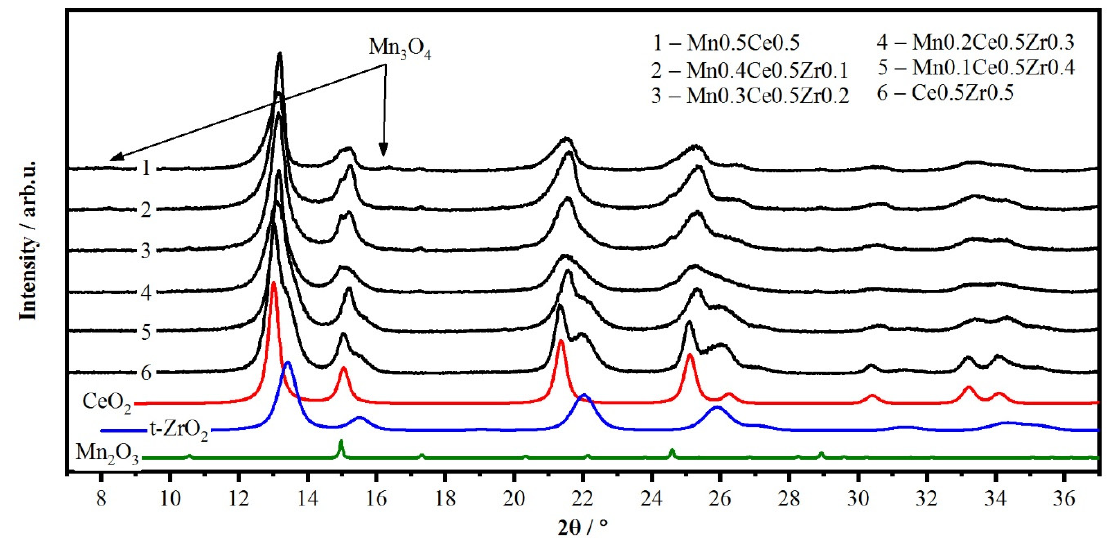
Figure 2. XRD patterns of (Mn,Zr)0.5Ce0.5 catalysts and peak positions of phases CeO 2 (PDF No.